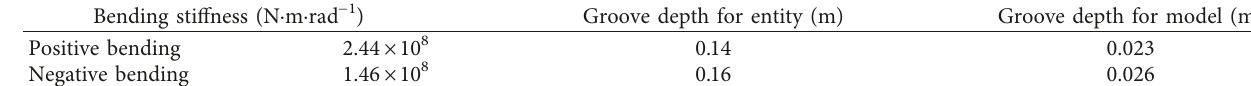
Table 5: Gap depth of segment transverse joints.